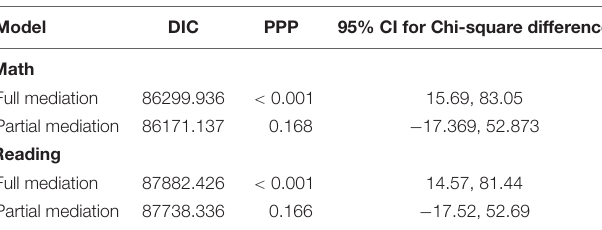
TABLE 4 | Model fit statistics by model.